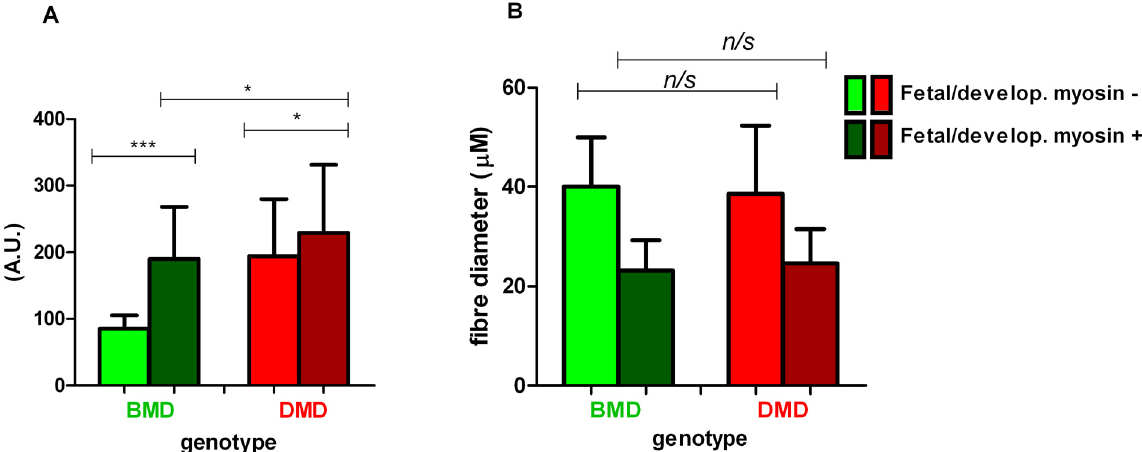
Fig 3. Quantification of utrophin intensity on regenerating fibres in BMD and DMD. (A). Utrophin intensity (arbitrary units; A.U.) and (B) fibre diameter quantified in both fetal and developmental (fetal/develop) myosin negative (light green/red) and positive (dark green/red) muscle fibres in 3 BMD (P5, 6 and 7) and 6 DMD (P9, P10, P11, P12, P14 and P15) (pooled analysis). A single sarcolemmal utrophin measurement was taken from randomly selected fetal and developmental myosin positive and negative fibres from 4 fields of view in areas of muscle regeneration. (n = 39) for P3, (n = 27) for P7, (n = 46) for P8, (n = 60) for P2, (n = 45) for P3, (n = 55) for P4, (n = 53) for P17, (n = 25) for P19 and (n = 49) for P21 where n = total number of fetal/developmental myosin positive and negative fibres analysed for each muscle biopsy. A Kruskal-Wallis one way analysis of variance followed by Dunn ’ s test was performed (median and IQR depicted; * p < 0.05; *** p < 0.001, n/s, not